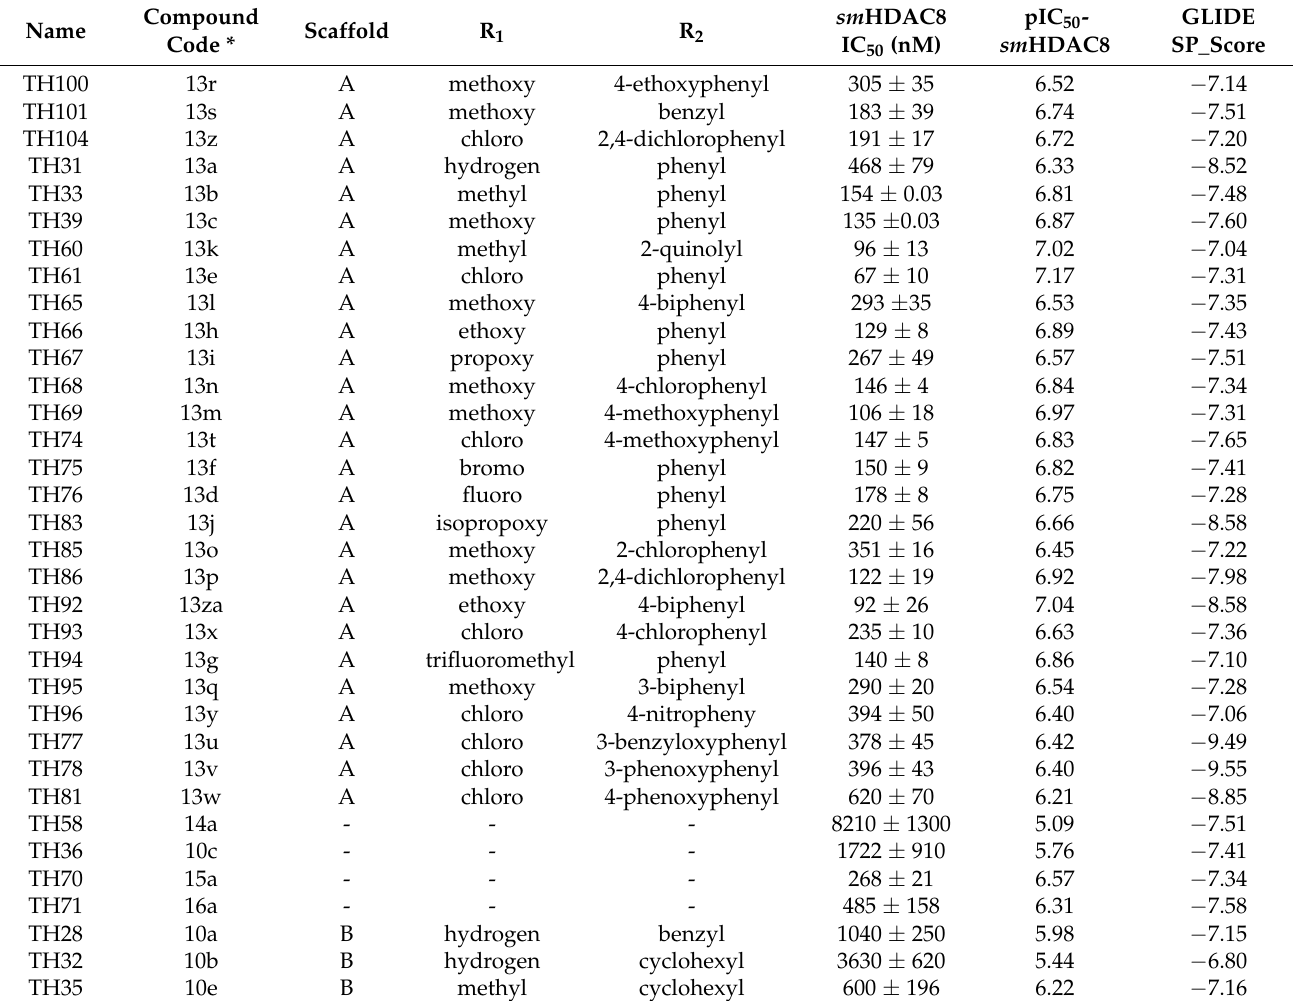
Figure 1. Training set molecules. Table 1. Training set molecules and their respective experimental pIC 50 and SP-Docking